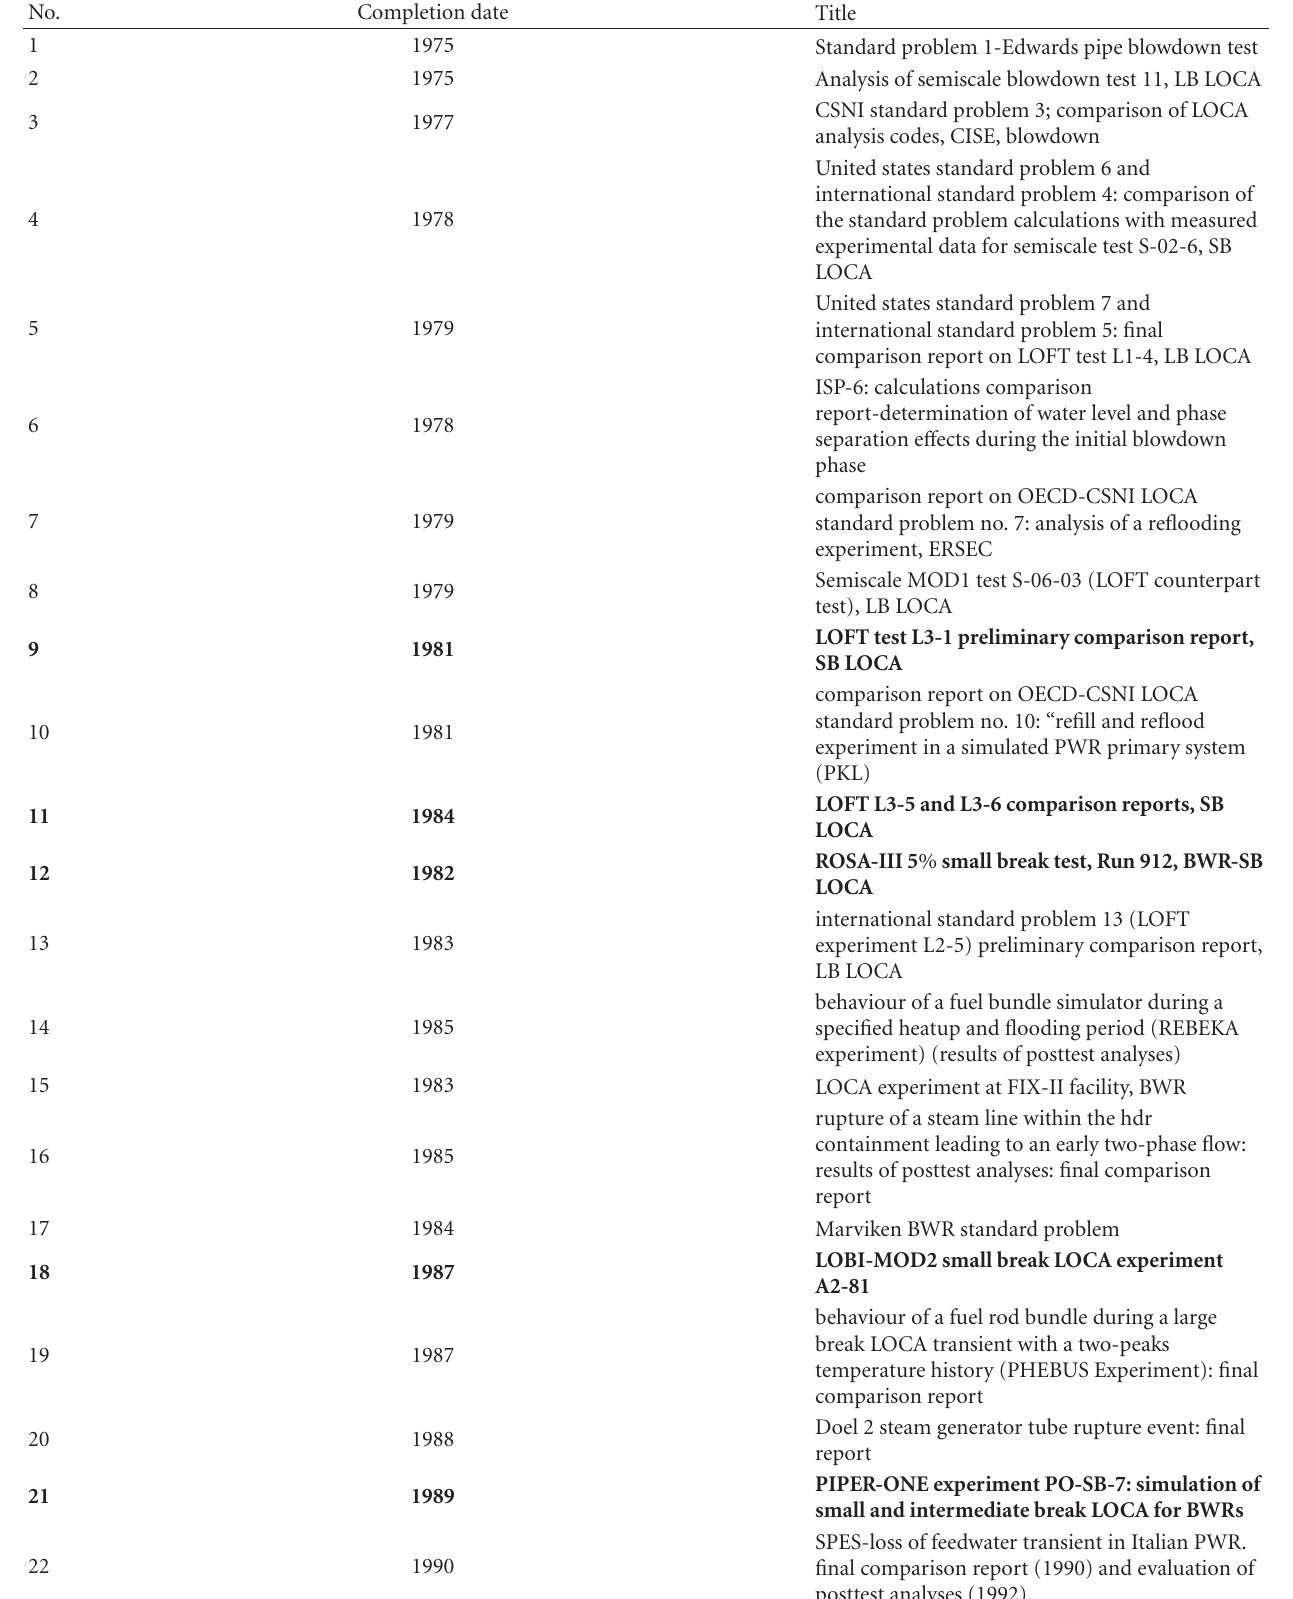
Table 1: List of CSNI international standard problems (ISPs)